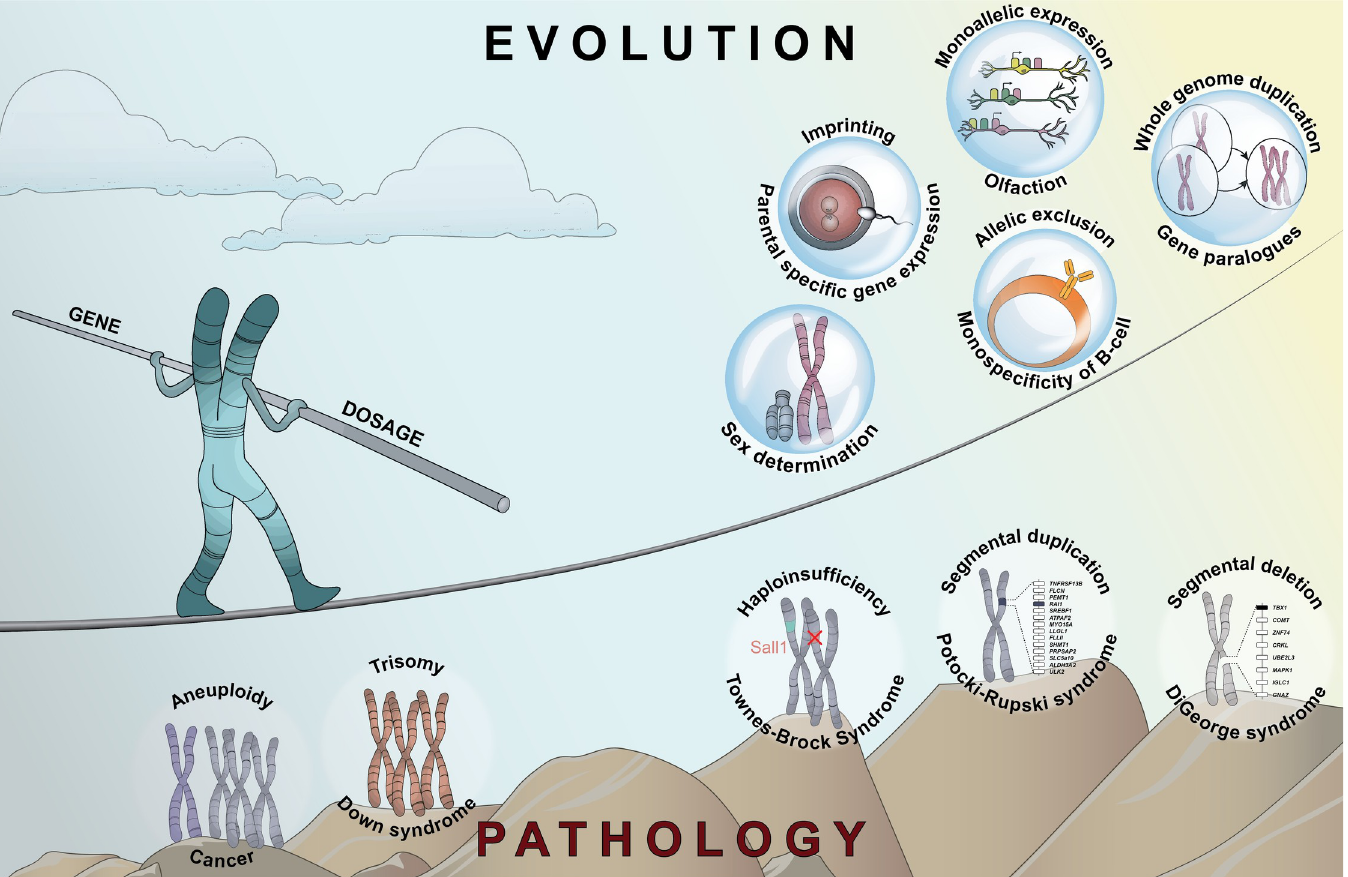
Fig 1. Overview of chromosome-wide to gene-by-gene dosage alterations. Artistic representation of the beneficial and the disadvantageous aspects of gene dosage alterations. Examples of naturally occurring and disease-causing phenomena are shown in the illustration. Such gene dosage alterations can occur from any level, from the chromosome-wide, i.e., mega-base scale, down to the individual gene level, i.e., a single-nucleotide change. Dosage can be modulated by genetic and epigenetic mechanisms.